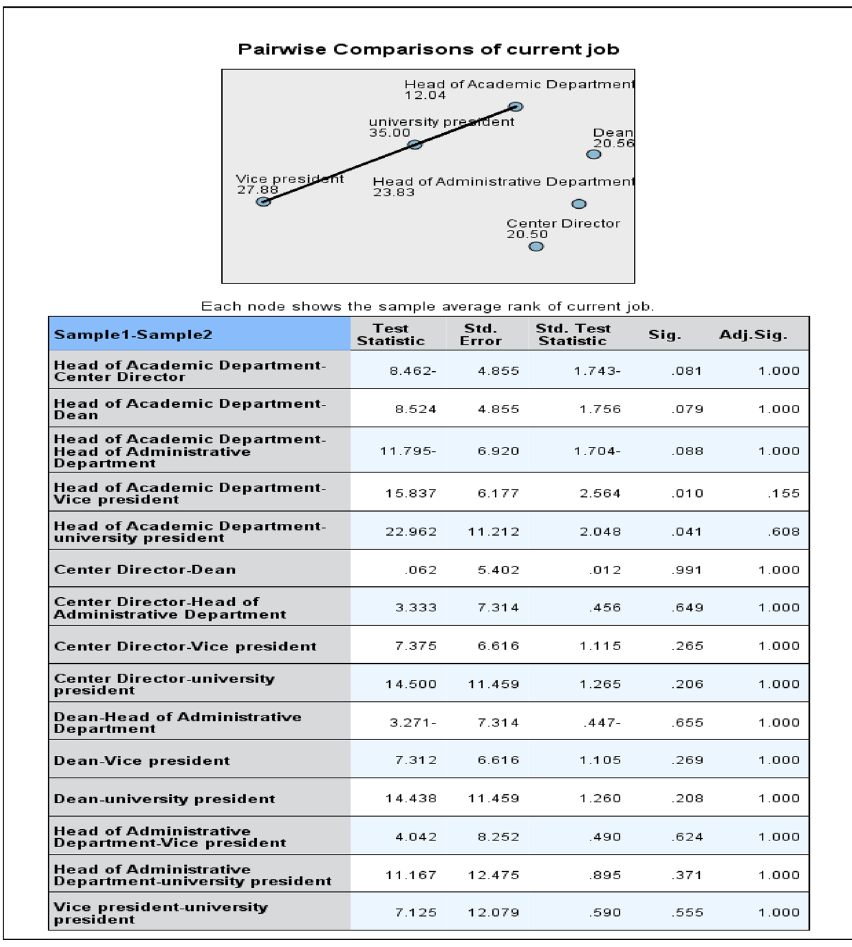
Fig. 2 Pairwise comparisons towards leadership according to the current